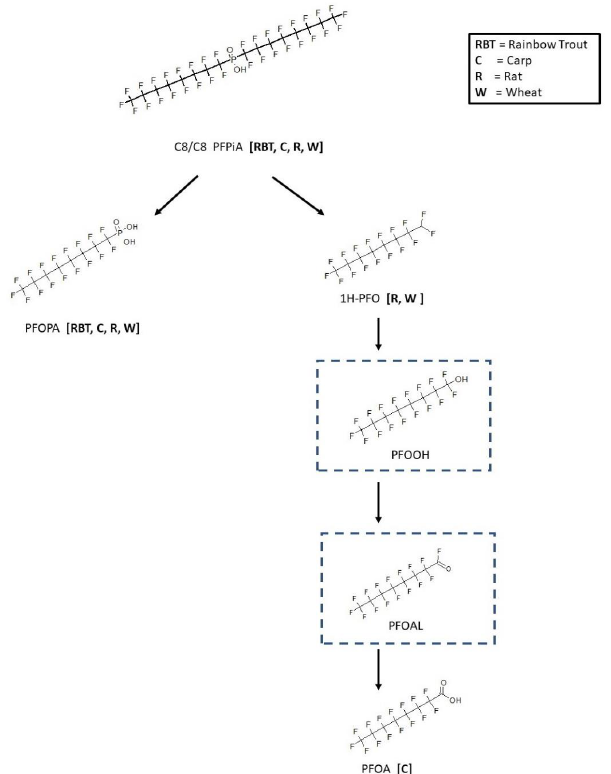
Figure 7. Metabolic map for bis(perfluorooctyl)phosphinic acid (C8/C8 PFPiA) as found in rainbow trout [16], rat [17], carp [18], and wheat [19]. Structures as shown within the dotted box were assumed by the authors but were not actually observed metabolites in the studies.